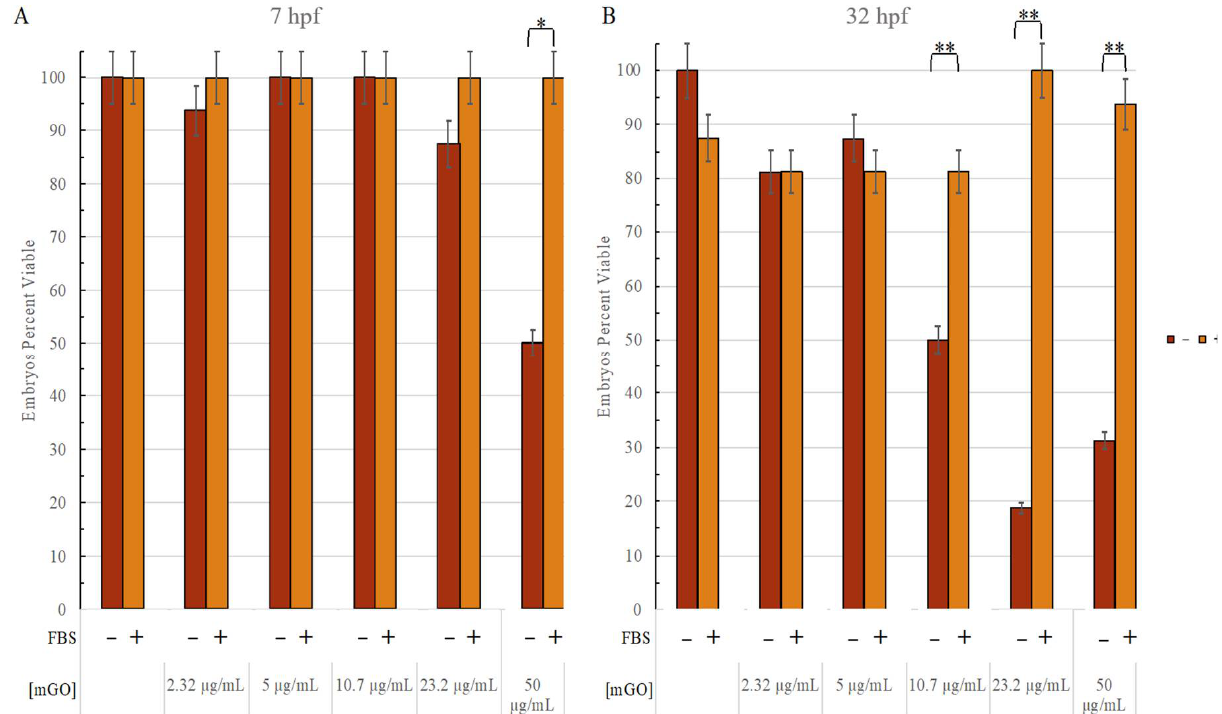
Figure 8. UP + mGO toxicity compared to FBS + mGO toxicity for 26 hpf. Red bars indicate the percent viability for the embryos that were exposed to mGO alone; orange bars indicate the percent viability for mGO + 4% FBS-exposed embryo. Concentrations found below the UP and FBS groups indicate the increasing mGO concentration in the solution (0 µ g/mL, 2.32 µ g/mL, 5 µ g/mL, 10.7 µ g/mL, 23.2 µ g/mL, 50 µ g/mL). Minor lines on the y-axis indicate a 5% change. ( A ) There was a significant difference between the mGO-only group and the FBS + mGO group at the highest concentration (50 µ g/mL) 1 h post-exposure (7 hpf). ( B ) The 32 hpf magnifies the trends that were starting to appear at 7 hpf. As observed in the range-finding portion of this study, 10.7 µ g/mL was the LEL in the embryos exposed to mGO only. On the other hand, this effect was not reflected in the embryos exposed to the FBS mixture. *: p ≤ 0.01. **: p ≤